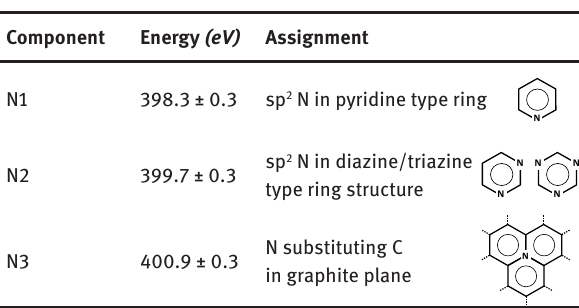
Table 1: Assignation of N1s components of the plasma treated nano- carbon materials.